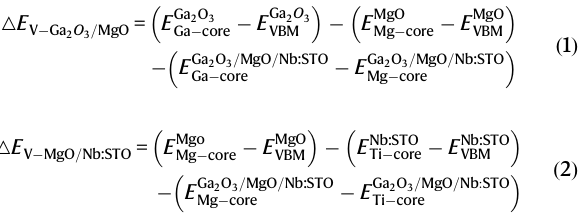
Fig. 5 | Performance comparison of the Ga 2 O 3 /MgO/Nb:STO nBn unipolar barrier APD with previously reported avalanche photodetectors (APDs) and photomultiplier tubes (PMTs). a Responsivity and detectivity versus gain.